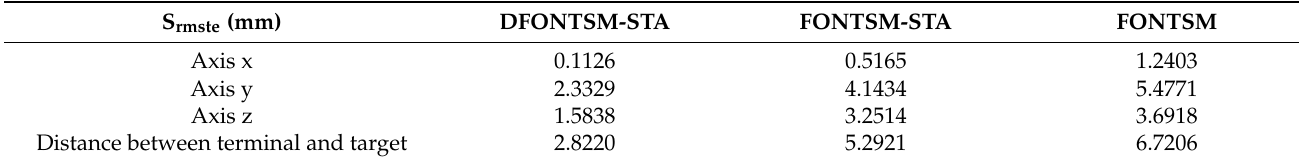
Table 9. Terminal position root mean square error.